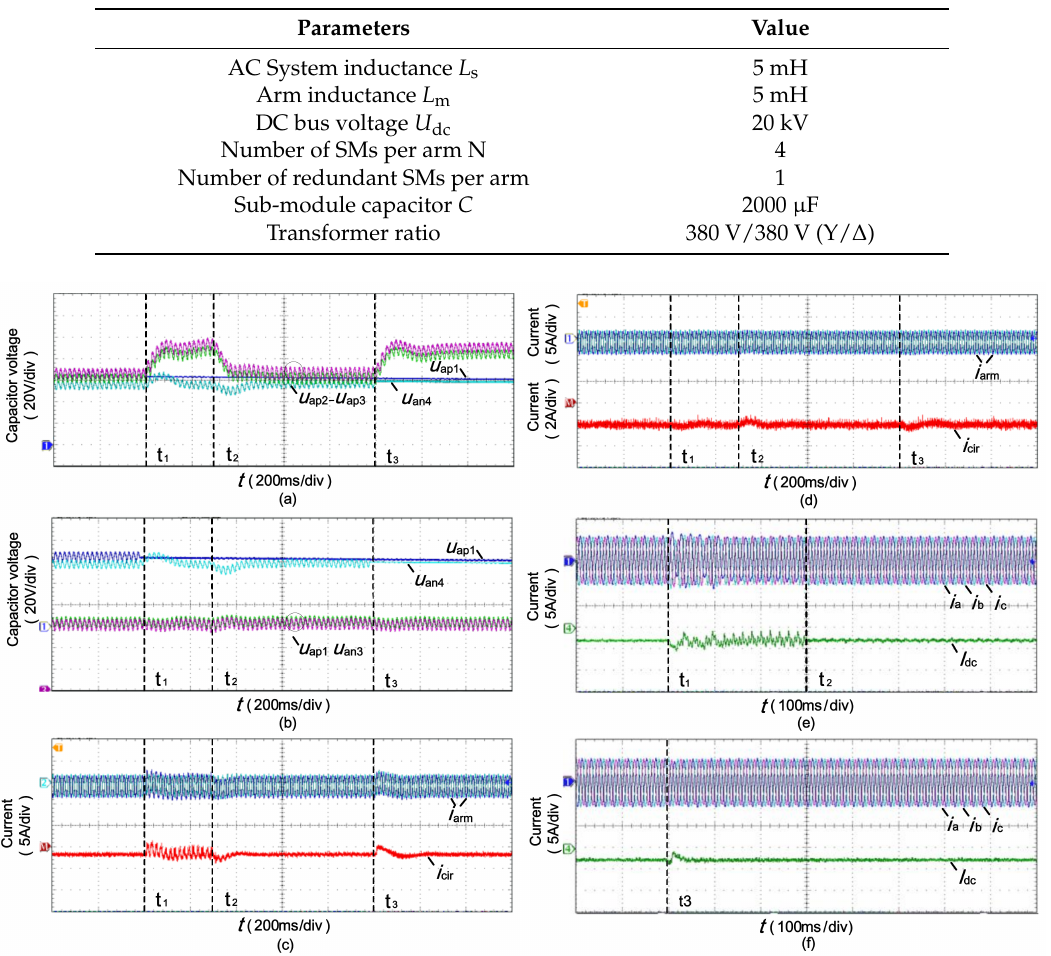
Figure 12. The photograph of MMC experiment prototype. Table 2. Experimental parameters of the MMC prototype.